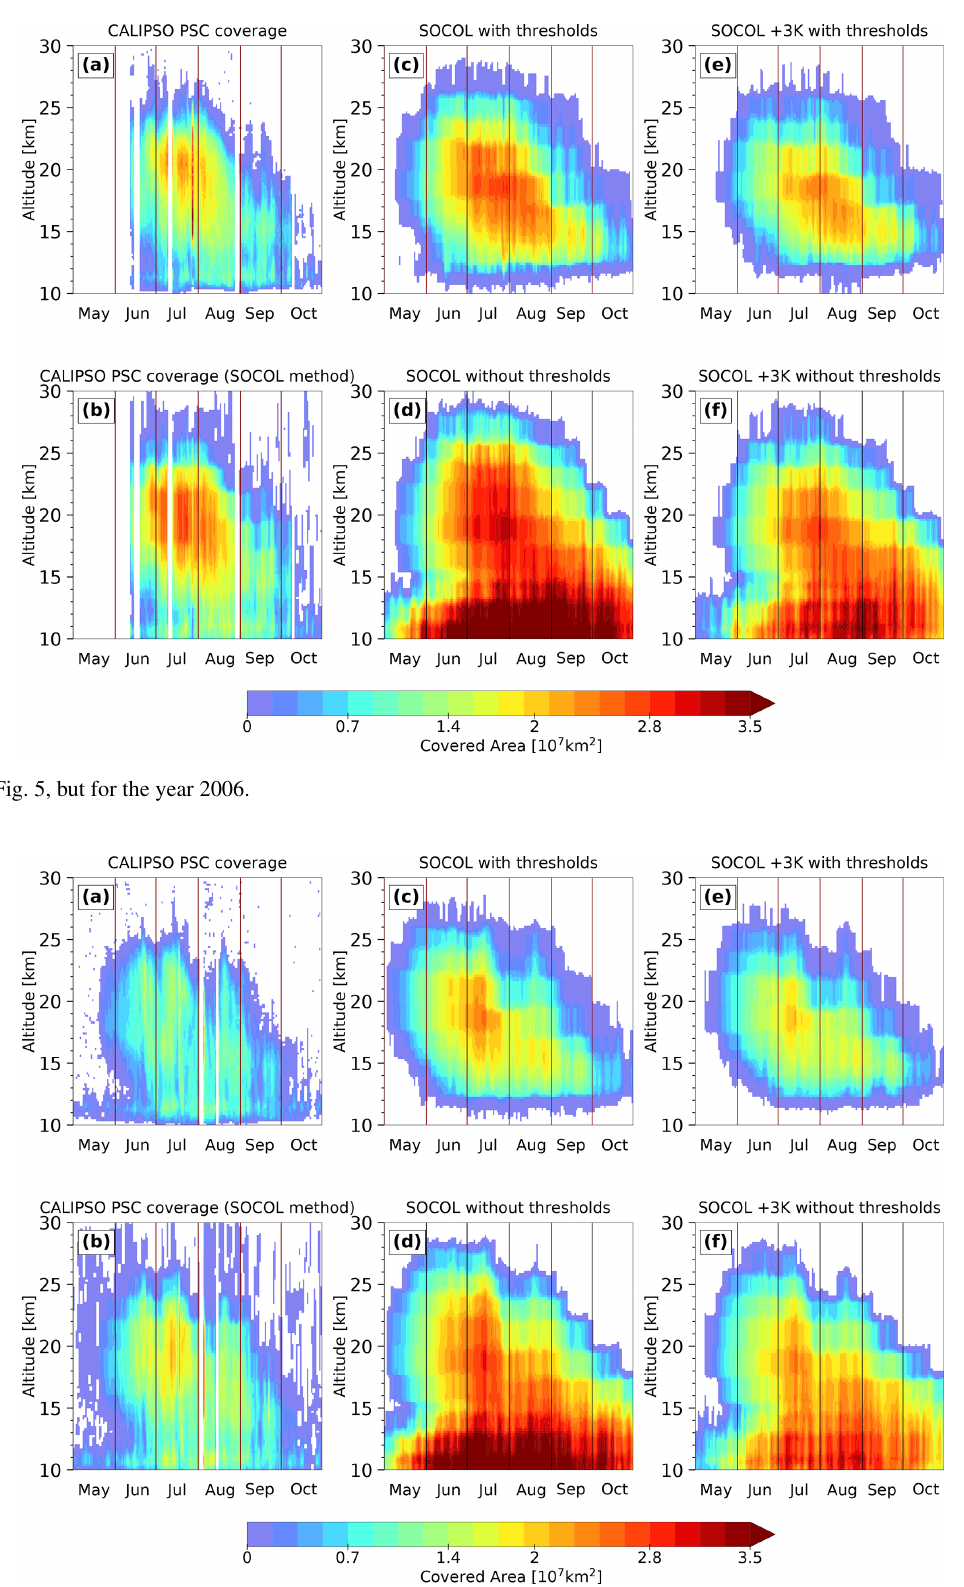
Figure A6. As Fig. 5, but for the year 2010.